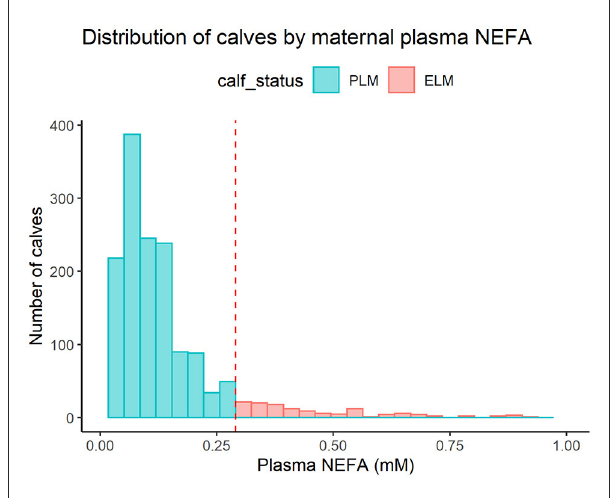
FIGURE2 Histogram for the distribution of calves by maternal plasma nonesterified fatty acids (NEFA) category. PLM (physiological lipid mobilization = 1,373; heifers = 630; bulls = 743; plasma NEFA < 0.3mM; blue), ELM (excessive lipid mobilization =